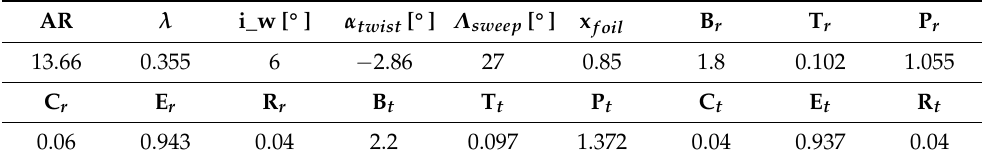
Table 2. Optimum variables for the case study.